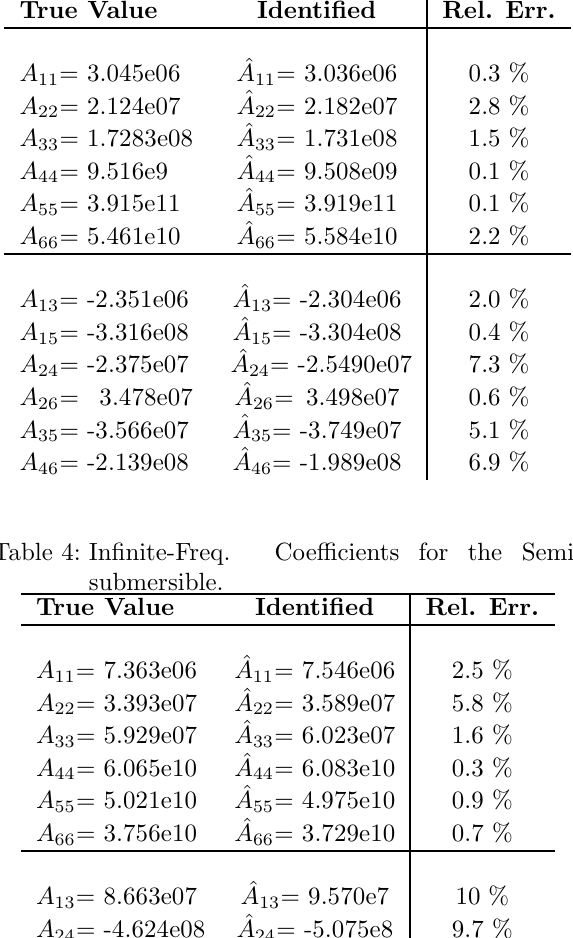
Table 3: Infinite-Freq. Coefficients for the FPSO. True Value